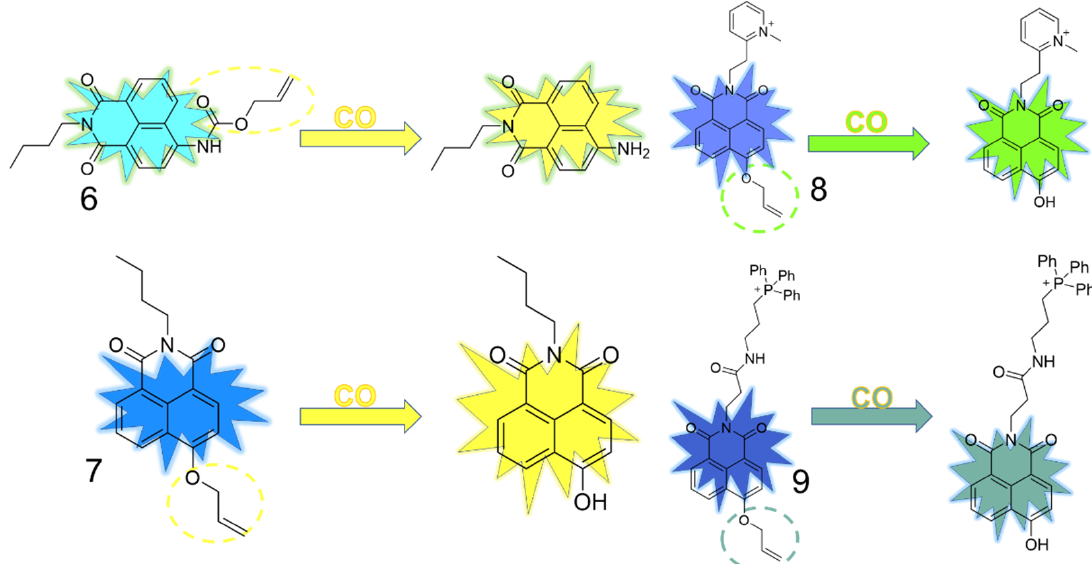
Figure 6. Some CO fluorescent probes constructed on the basis of naphthalimide fluorophores and their reaction detection mechanisms.